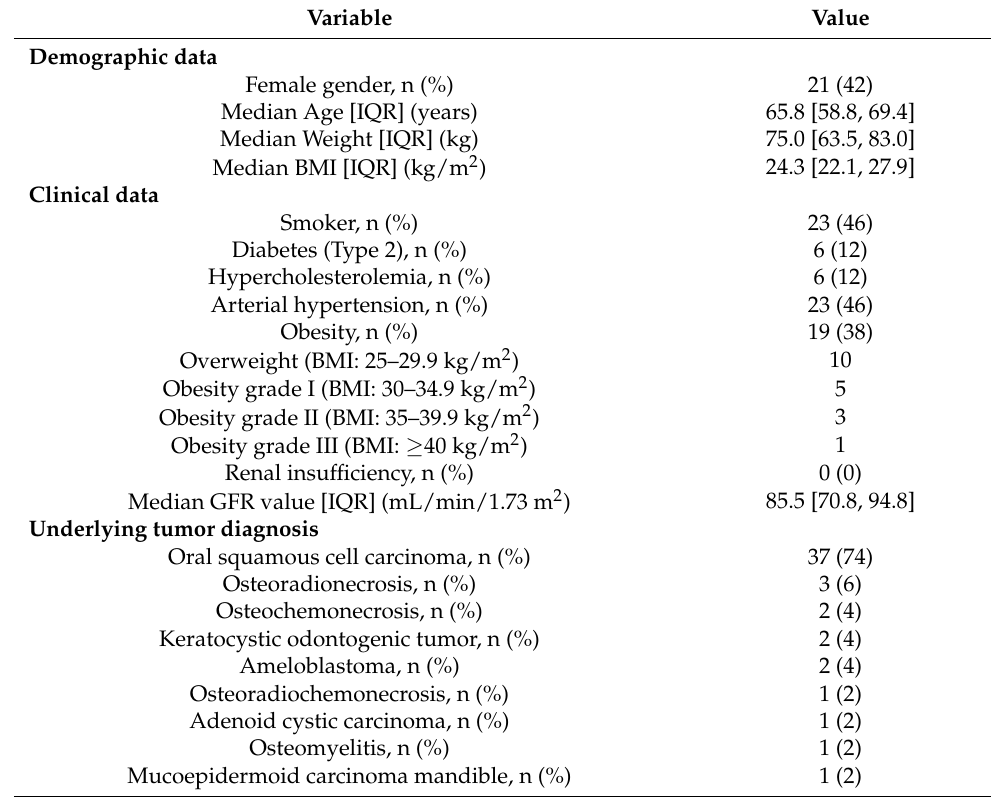
Table 1. Demographic and Clinical Characteristics Data of the Study Population. The values are given either as a number (n) and percentage or as the median with interquartile range